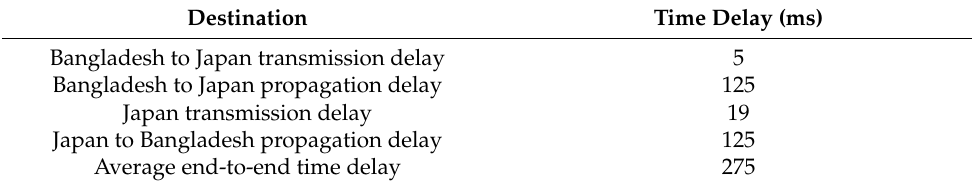
Table 4. Average end-to-end time delay to control the biobot.